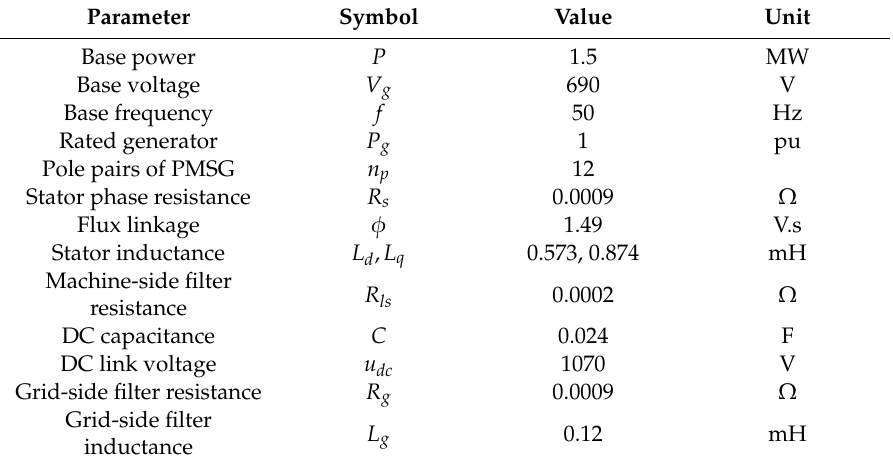
Table A1. Parameters of Direct-Driven Permanent Magnet Wind Power Inverter.